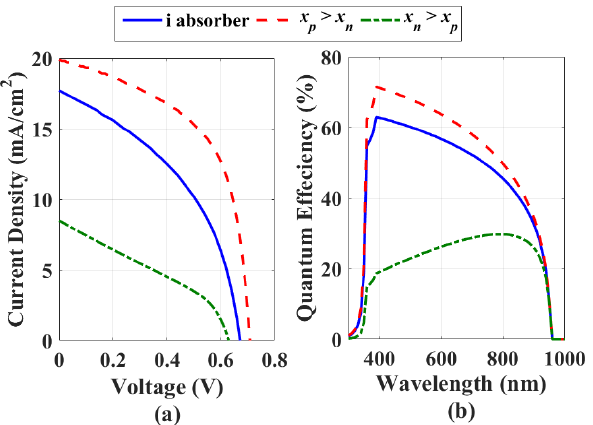
Figure 4. Impact of p-layer thickness on the photovoltaic parameters.